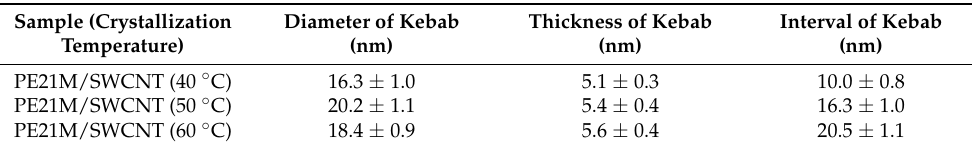
Table 1. The average size of PE21M lamellae formed on SWCNT based on the TEM images of 200 lamellae.